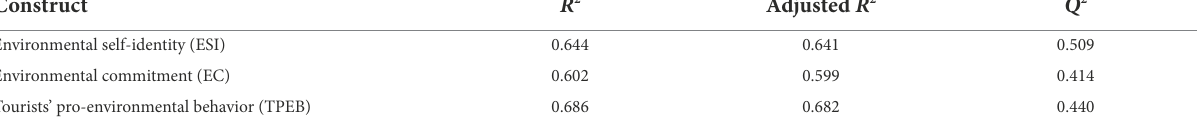
TABLE 5 Endogenous constructs assessment ( R 2 and Q 2